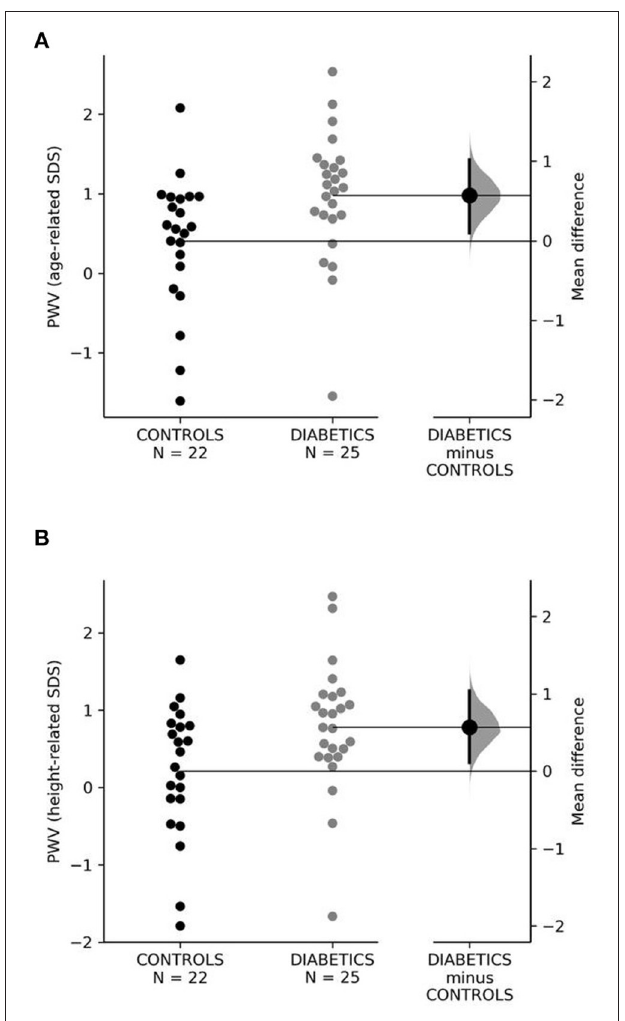
FIGURE 1 | (A,B) Age- and height-related SDS of PWV in control and diabetic groups. PWV, pulse wave velocity; SDS, standard deviation score.